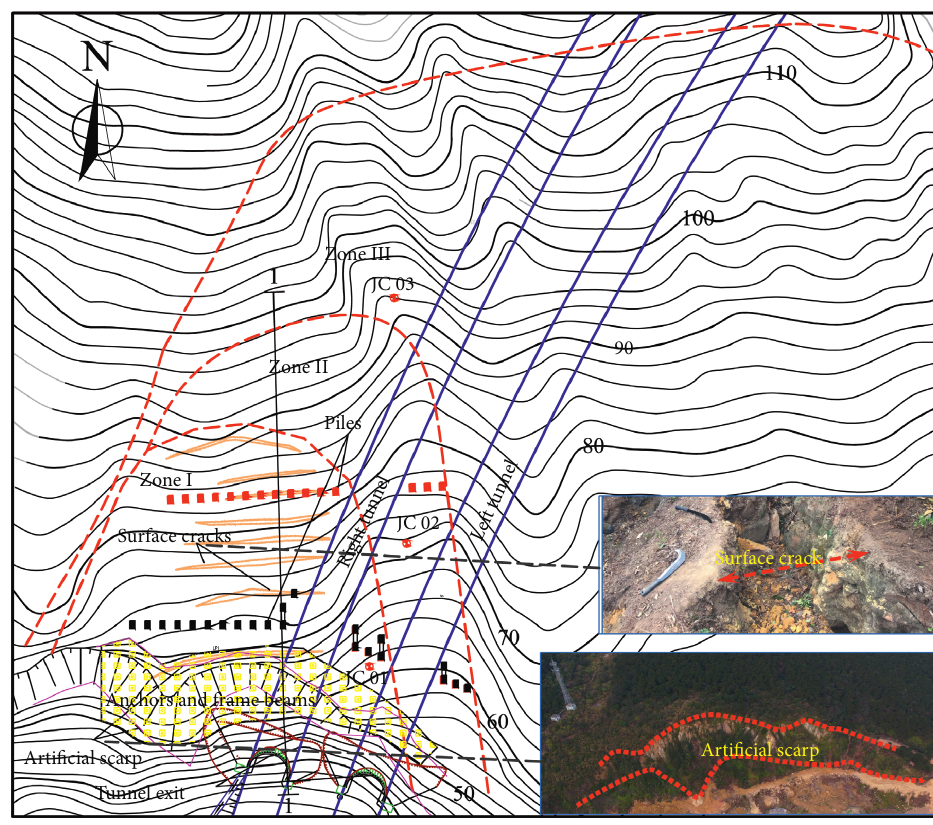
Figure 1: Layout of the tunnel and deposit slope.